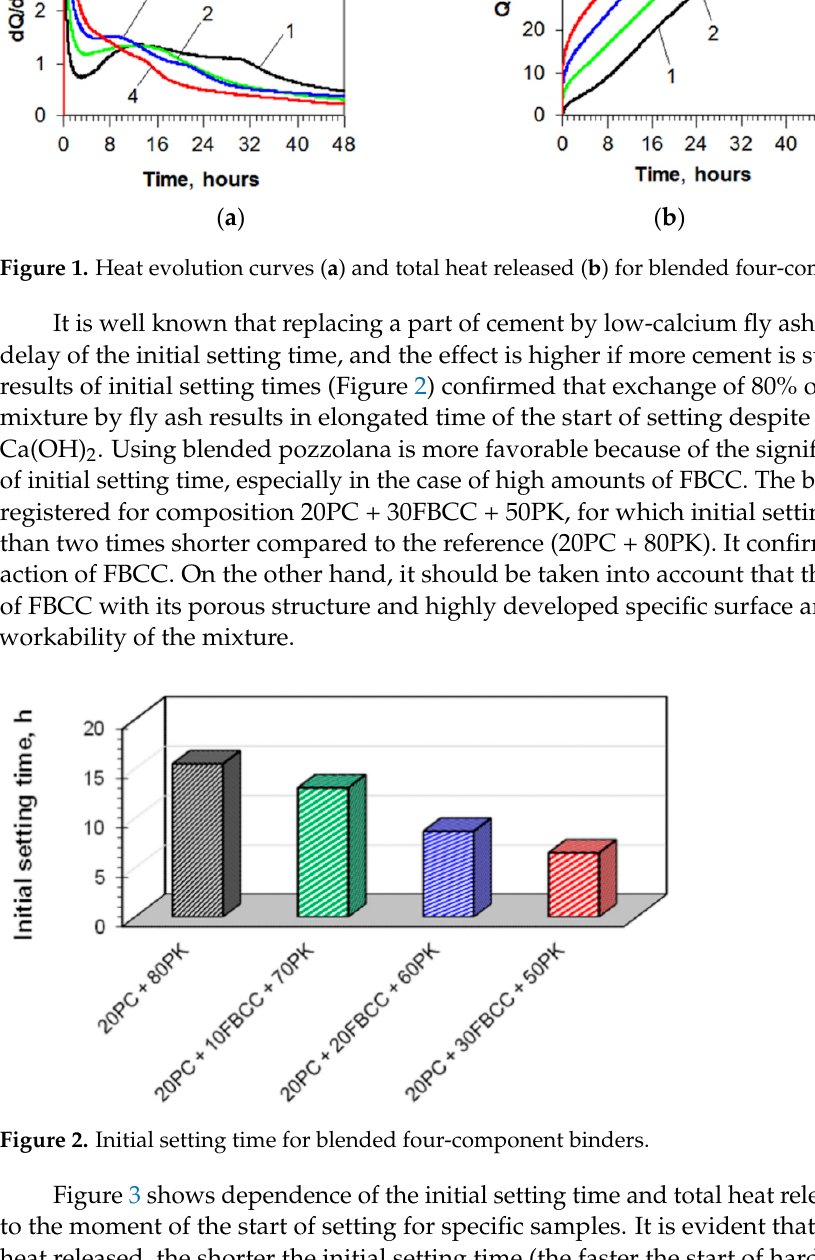
Figure 1. Heat evolution curves ( a ) and total heat released ( b ) for blended four-component binders.